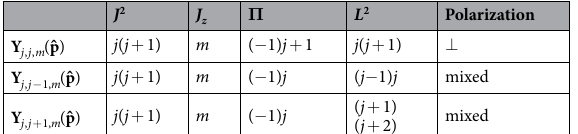
, Y 0,0,0 = 0, and 0,1,0